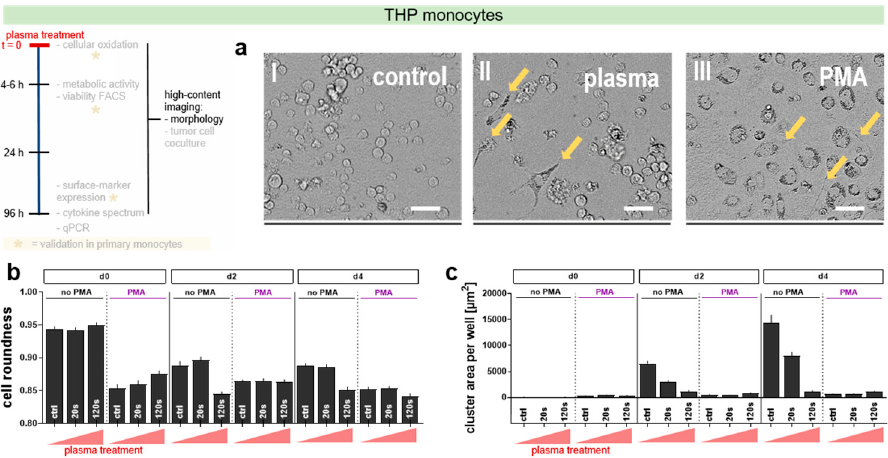
Figure 3. High content image quantification of morphological changes in THP-1 monocytes up to four days after plasma and / or PMA treatment. 5000 cells were seeded, plasma-treated, and / or PMA-pulsed, and imaged on d0 (4 h), d2 (24 h), and d4 (96 h), respectively. ( a ) The representative images on day 4 of untreated control cells (I), 120 s plasma-treated cells (II) and cells that were exposed to PMA alone (III). The yellow arrows point to di ff erentiated cells with cellular extensions; ( b ) Quantification of cell roundness and, ( c ) quantification of total cell cluster area. Approximately 10,000 single cells per treatment condition were analyzed via computer algorithms. The data are presented as the mean + SEM of three independent experiments with four technical replicates each. The scale bars = 100 µ m. Seconds (s) indicate plasma treatment time, ctrl = control.